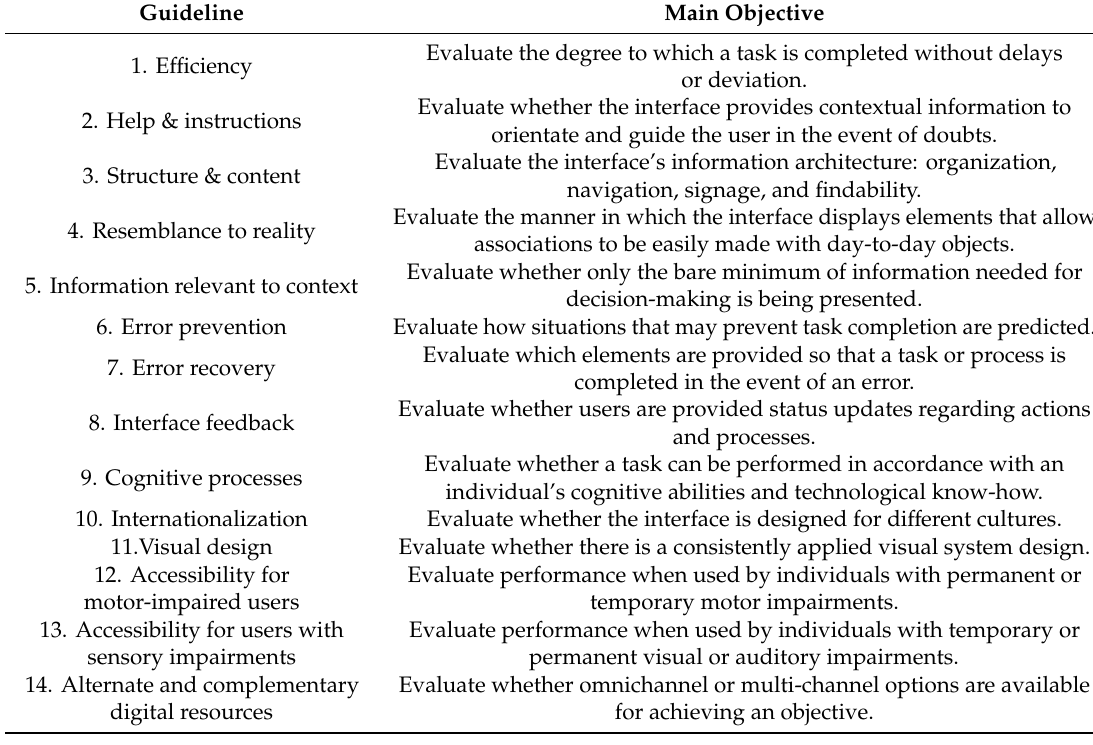
Table 2. Guidelines for Evaluating User Experience in Urban